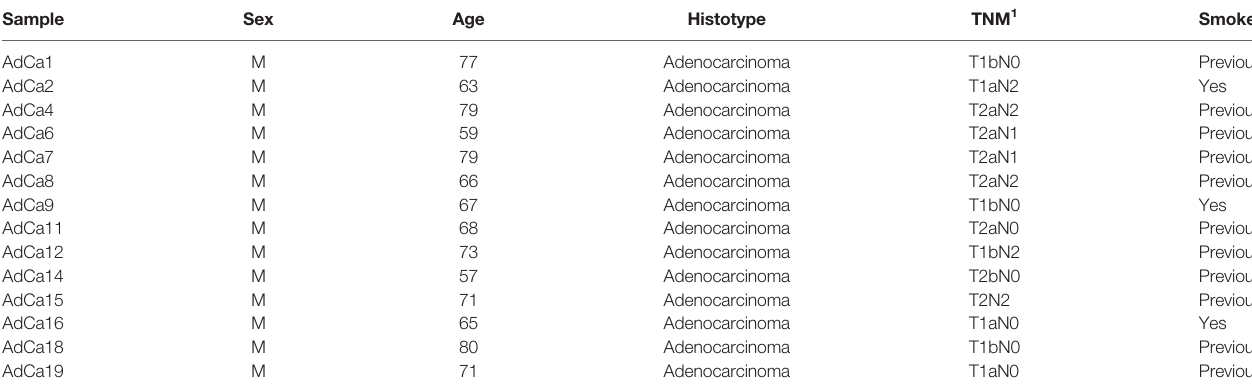
TABLE 1 | Clinicopathological features of the 14 patients affected by AdCa.